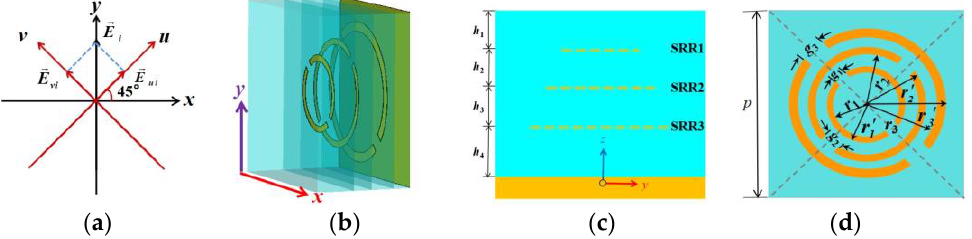
Figure 1. Schematics of the u – v coordinate system and the proposed MPC UC. ( a ) The electric field decomposition of the incident wave in the u – v coordinate system. ( b ) 3D perspective, ( c ) side view, and ( d ) top view of the UC.